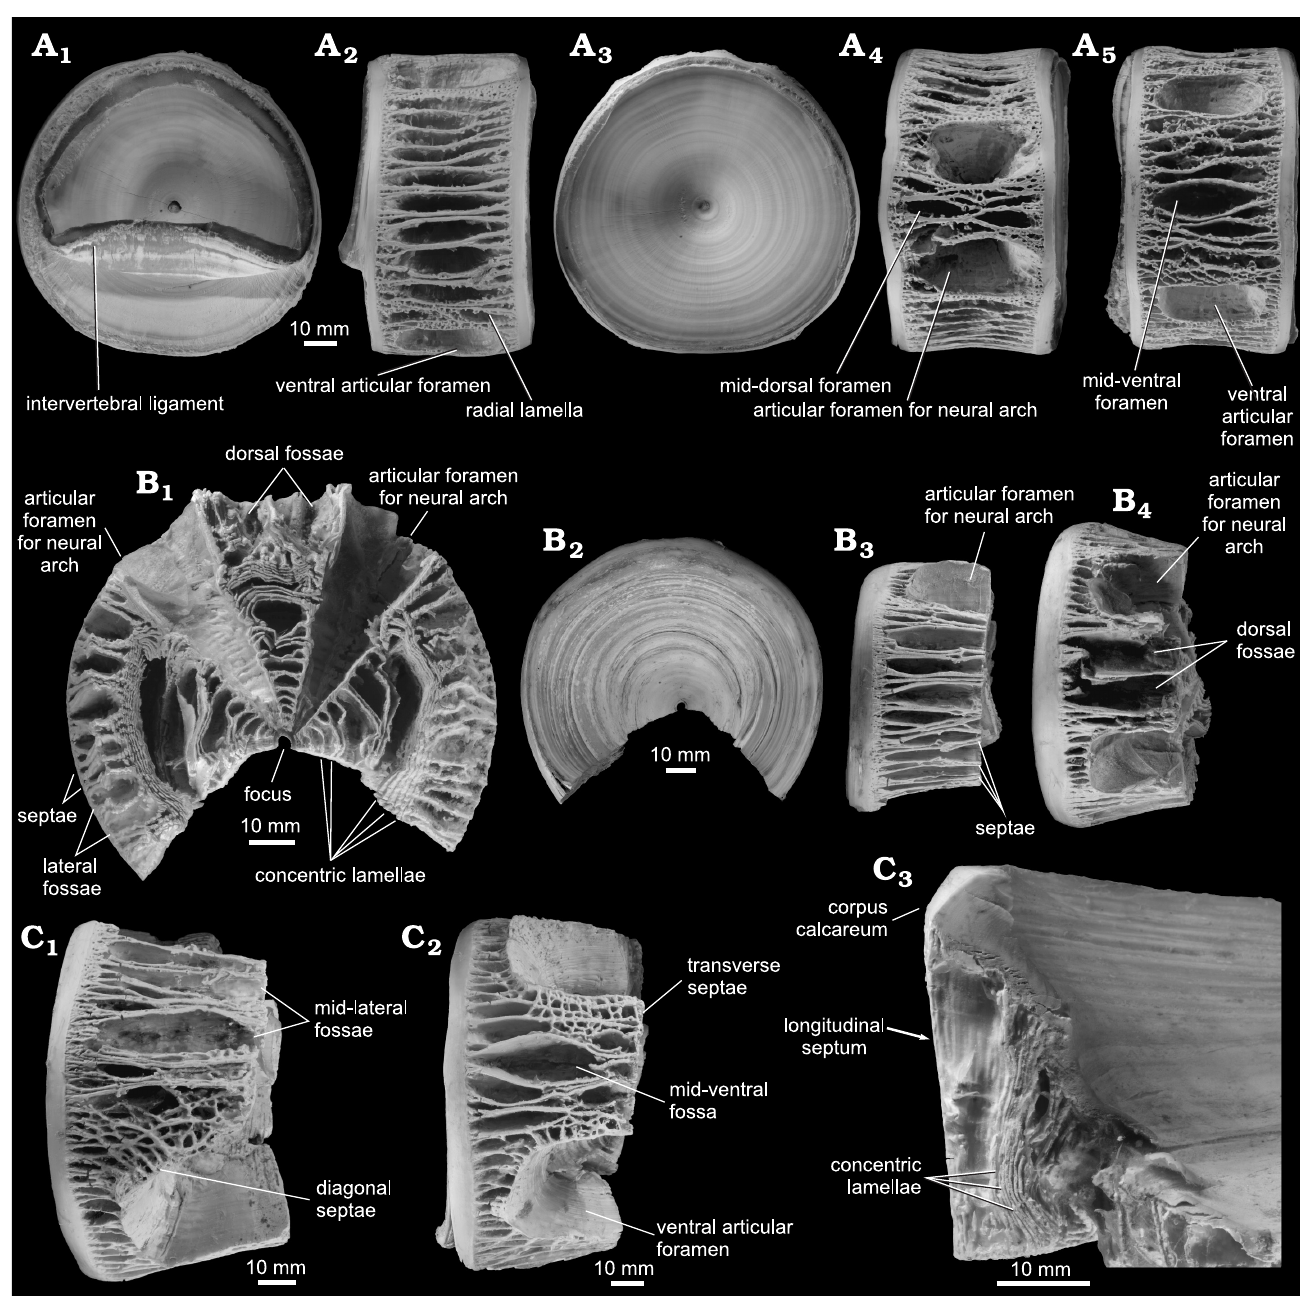
Fig. 9. Centra from extant Carcharodon carcharias Linnaeus, 1758 ( A ) and Cetorhinus maximus Gunnerus, 1765 ( B , C ). A . Centrum, LACM I-35875- 1, in anterior (A ), left lateral (A ), posterior (A ), dorsal (A ), and ventral (A ) views. B . Partial centrum (LACM I-35593-1a) in transverse section (B 1 2 3 4 5 posterior (B ), left lateral (B ), and dorsal (B ) views. C . Partial centrum (LACM I-35593-1b) in left lateral (C 2 3 4 (C ) 3